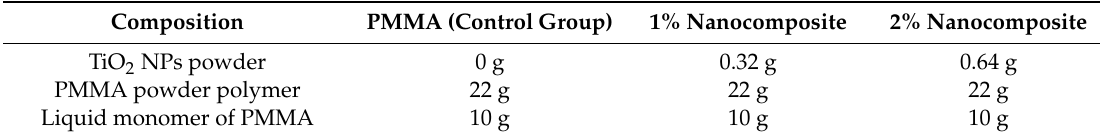
Table 1. Composition of particular